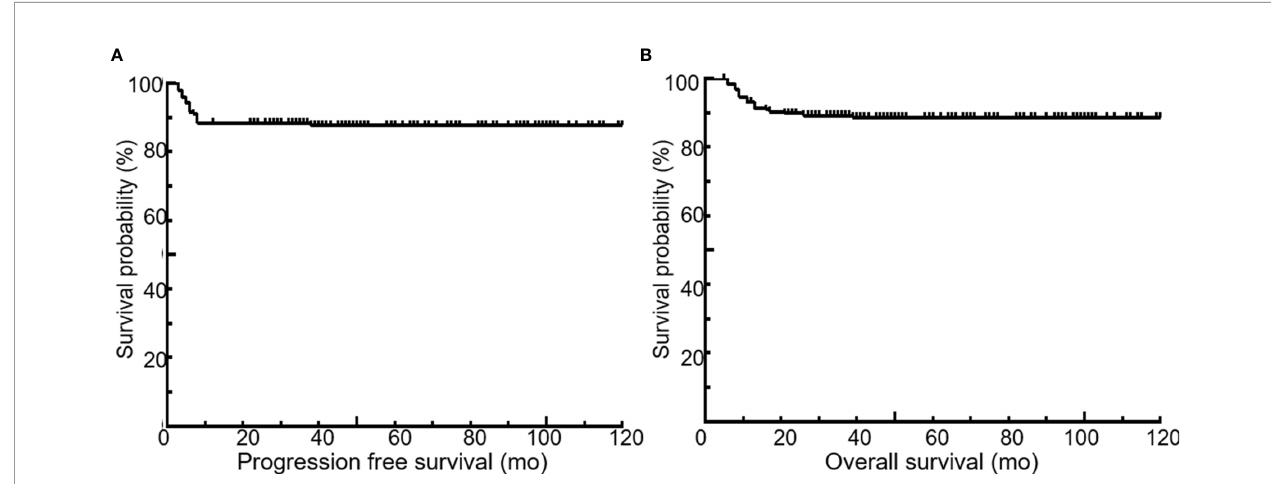
FIGURE 3 | Kaplan-Meier curves for PFS (A) and OS (B) of the entire patient population. Five-year PFS and OS, 88.3% and 89.3%,